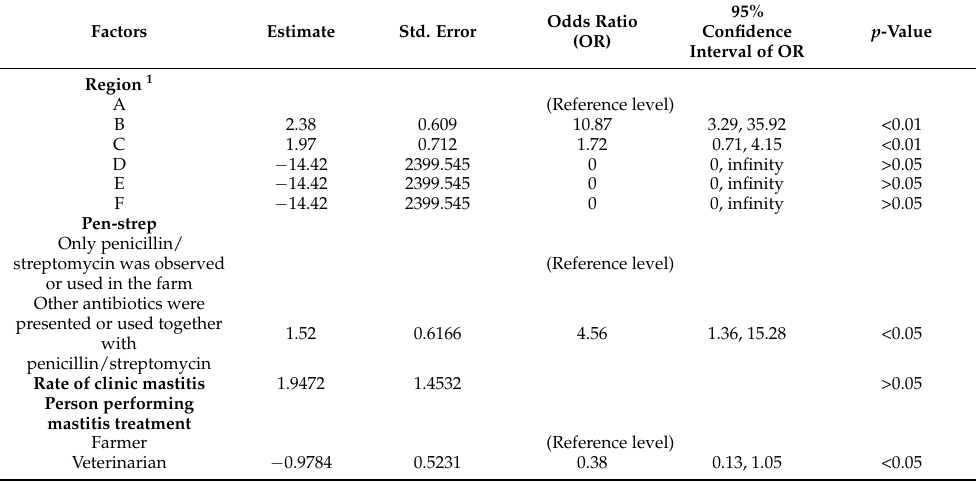
Table 6. Variables in the final logistic regression model for the presence of antibiotic in bulk tank milk in the 3 month period 9.